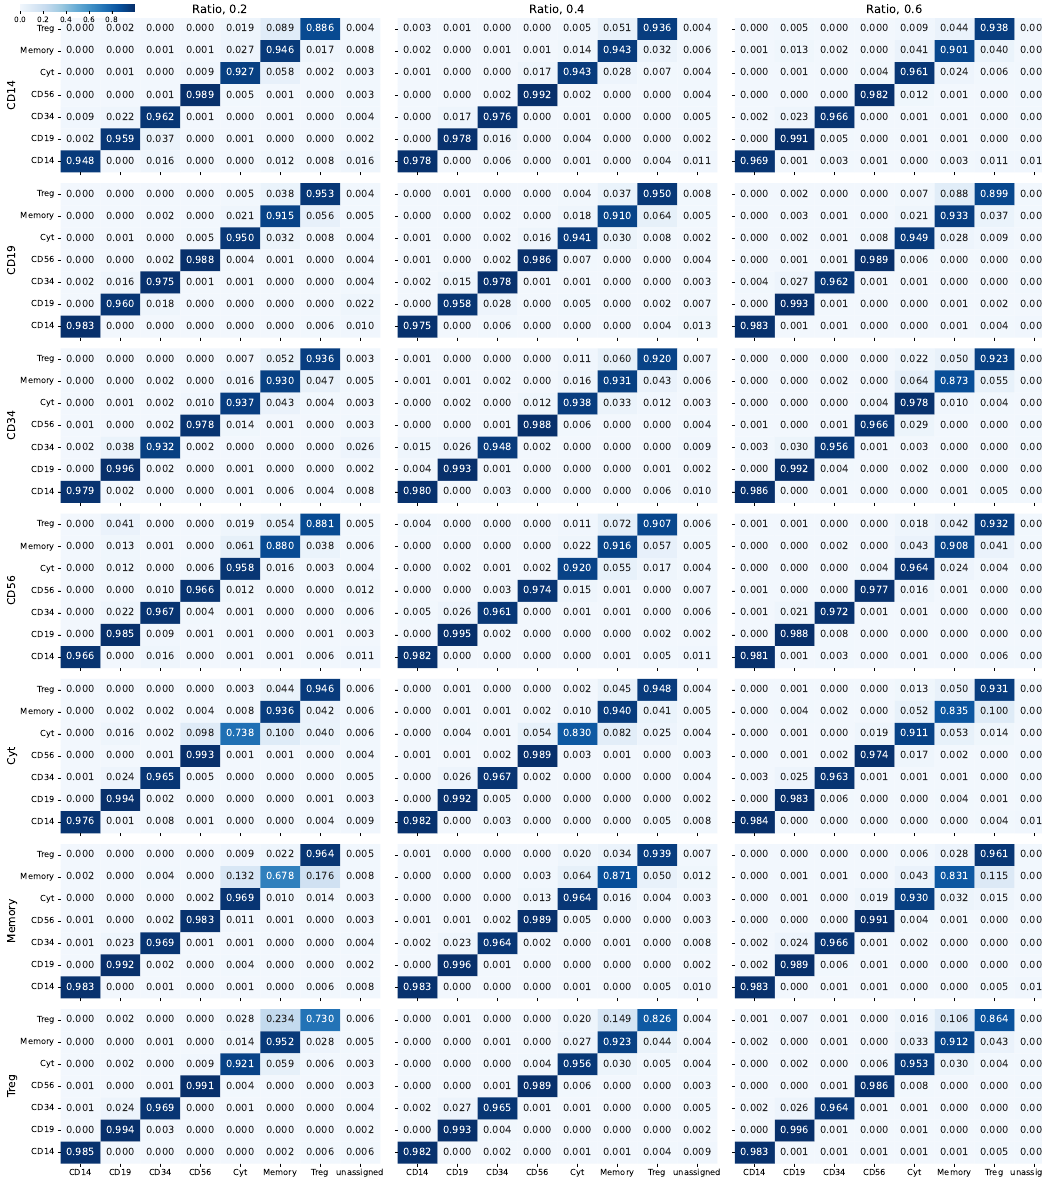
Figure 5. Summarized confusion matrices for the different unbalanced simulations using the PBMC dataset. The rows represent the cell type being undersampled, while the columns are the fraction of cells kept for each cell